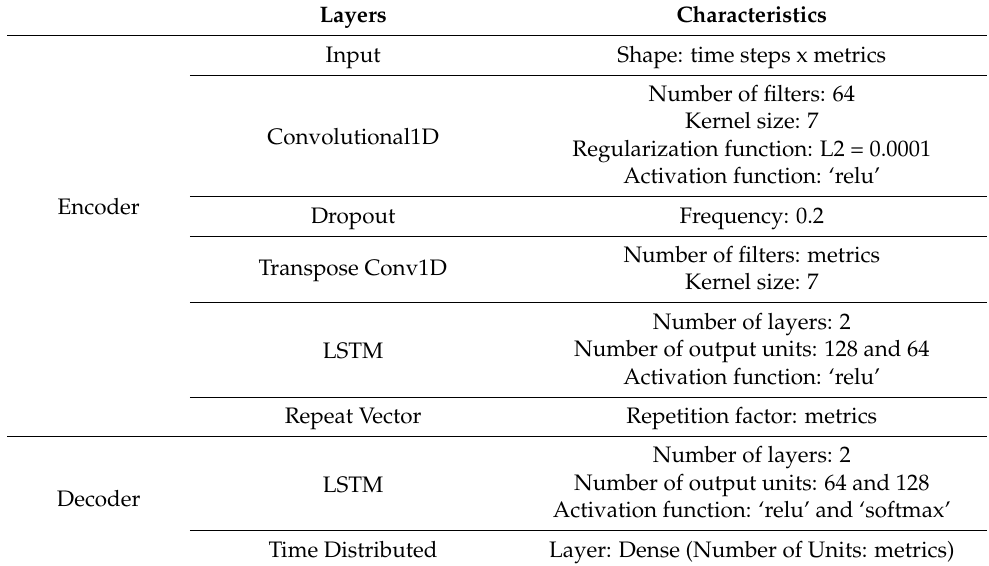
Table 1. Characteristics of the